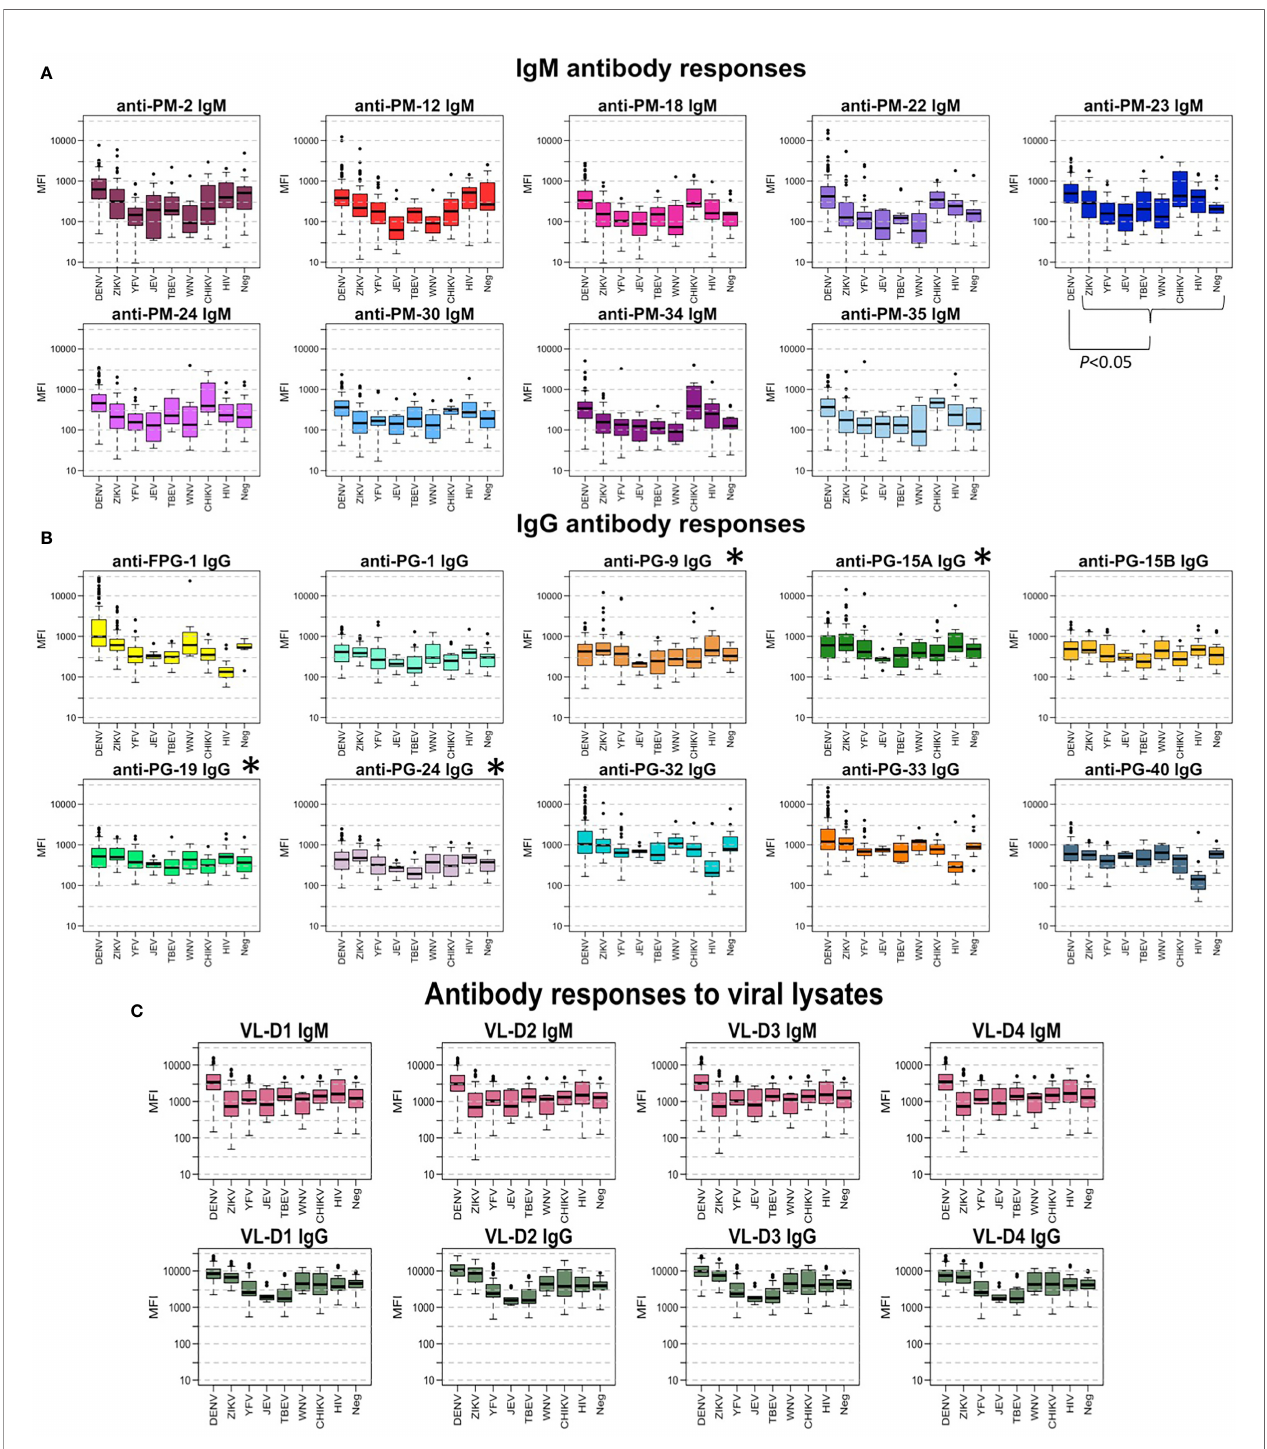
FIGURE 2 | Antibody responses to peptide biomarkers. (A) Boxplot display of the IgM response against the peptides in median fl uorescence intensity (MFI) values in serum samples for each virus group. Positive DENV samples (n = 137) where con fi rmed by RT-PCR in endemic patients and RT-PCR and/or IgM/IgG seroconversion in travelers. DENV-negative samples (n = 185) corresponded to ZIKV, YFV, TBEV, JEV, WNV, CHIKV, HIV, and negative controls from non-endemic healthy donors. Horizontal box boundaries and midline denote sample quartiles. (B) Boxplot display of the measured IgG against the biomarkers in MFI values in serum samples from each group. (C) Boxplot display of the measured IgM and IgG (MFI) against the viral lysates (entire proteome) of the four DENV serotypes in serum samples from each group. Signi fi cant differences (P<.05) between MFI values in DENV-infected individuals compared to the response from people with exposure to other fl aviviruses was found for all peptides, except for those labeled with